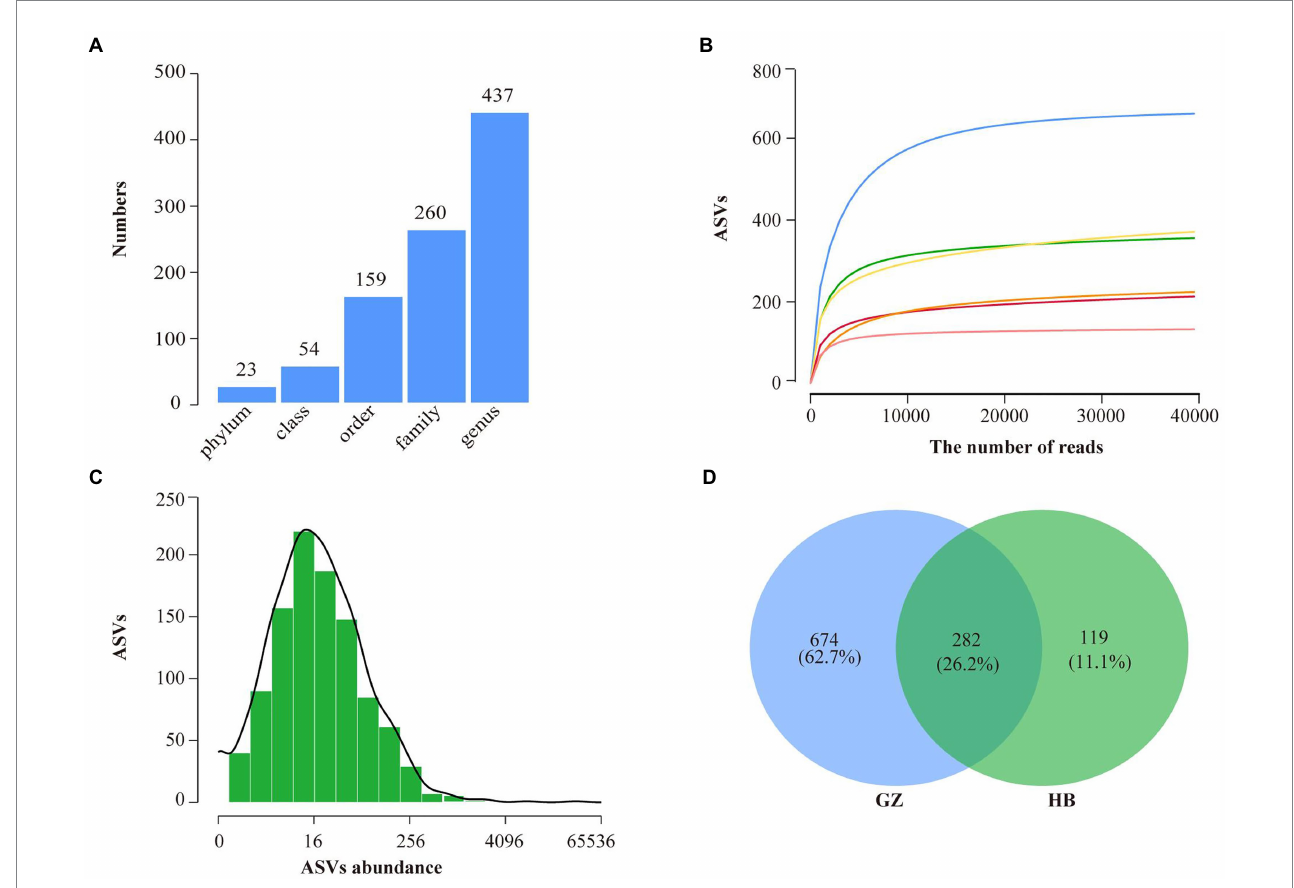
FIGURE 2 High throughput sequencing statistics and rank abundance curves. (A) ASV classification statistics. (B) ASV rarefaction curves. (C) Distribution of ASVs abundance of bacteria. (D) Venn diagram showing the number of shared and specific ASVs for each group.